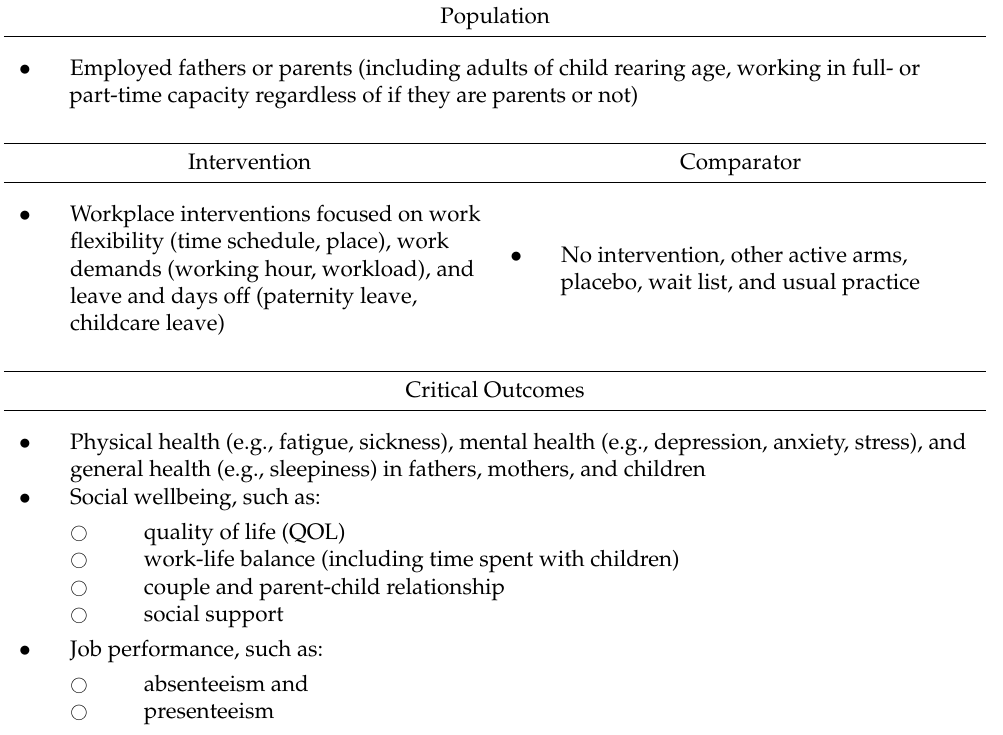
Table A1. Study PICO